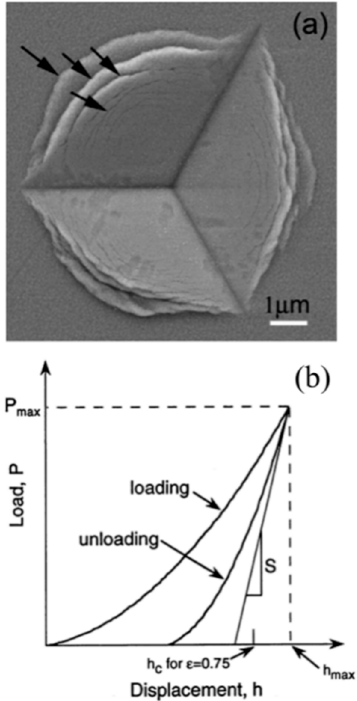
Figure 7. ( a ) SEM images of indents on Ag/Co multilayer. ( b ) Typical indentation load-displacement data defining key experimental quantities [37,44].